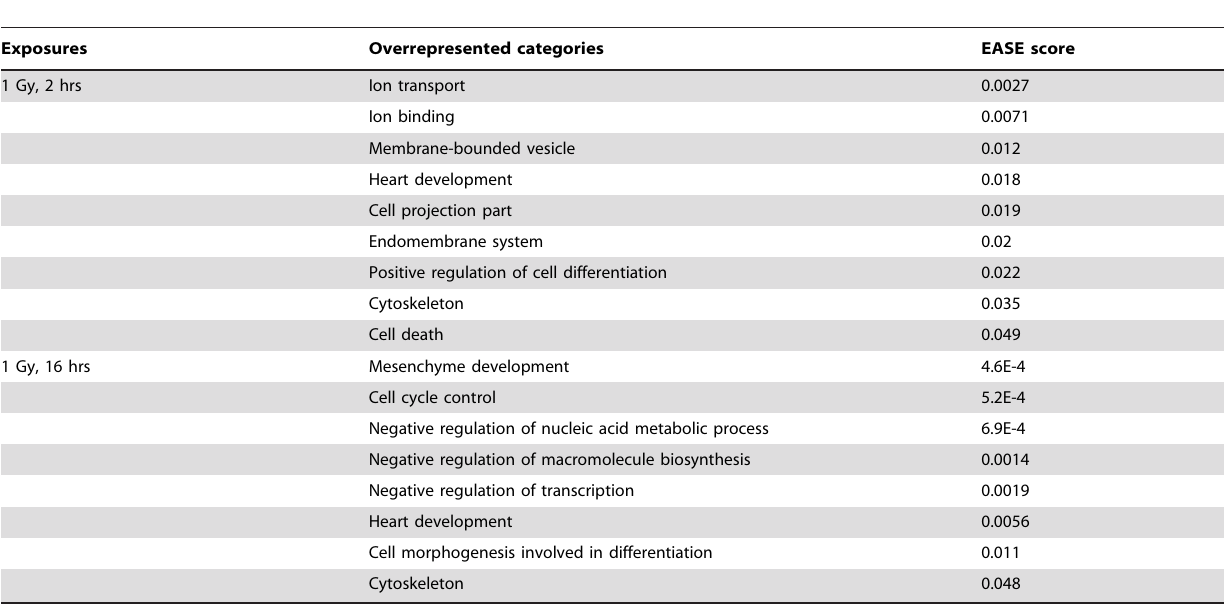
Table 7. Gene Ontology analysis of affected biological themes based on predicted miRNA targets in H9 cell line.